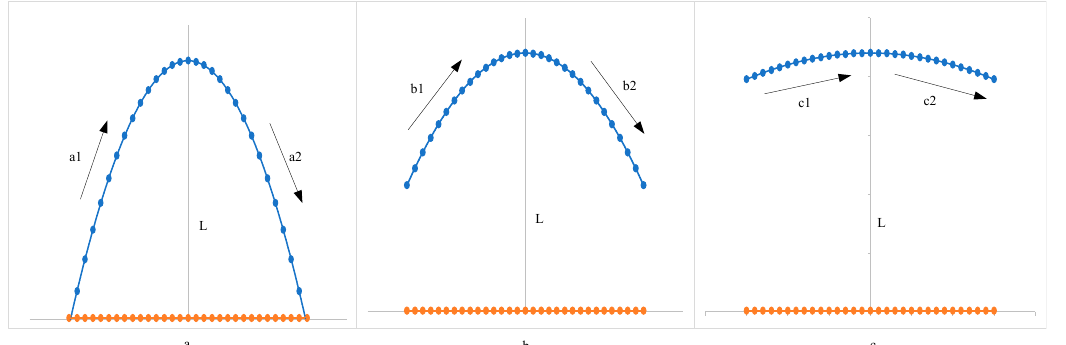
Figure 3. Increase in the coefficient of Indus could open the parabola wider. Figure 3, a1, b1, and c1 indicate the direction vector of the positive effect of Mi2 on GDP before the axis of symmetry (L). Figures a2, b2, and c2 are the direction vector of Mi2 on GDP after L.